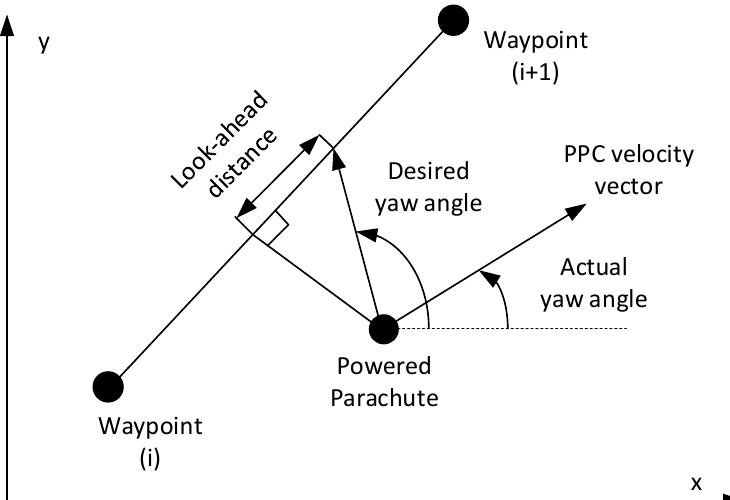
Figure 4. Look-ahead guidance algorithm.